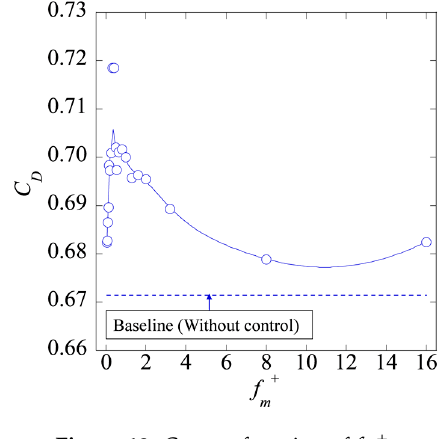
Figure 18. C D as a function of f m + .